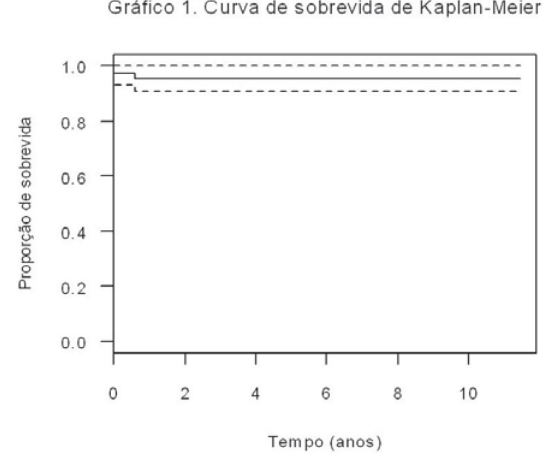
Fig. 3 - Curva de sobrevida de